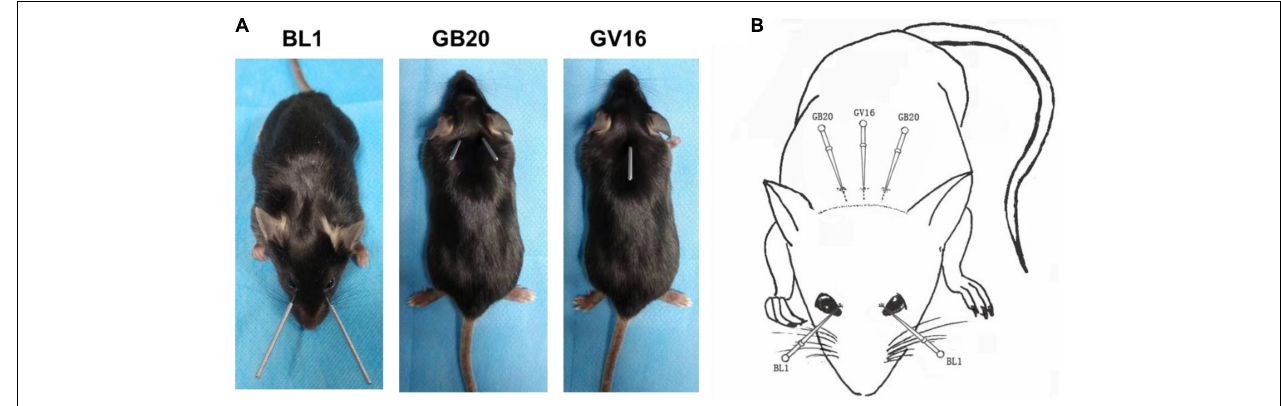
FIGURE 1 | The acupoints for acupuncture treatments. (A) Photos of mice showing the sites of acupuncture treatments at acupoints BL1, GB20, and GV16, respectively. (B) Schematic image demonstrating acupoint sites on mouse.